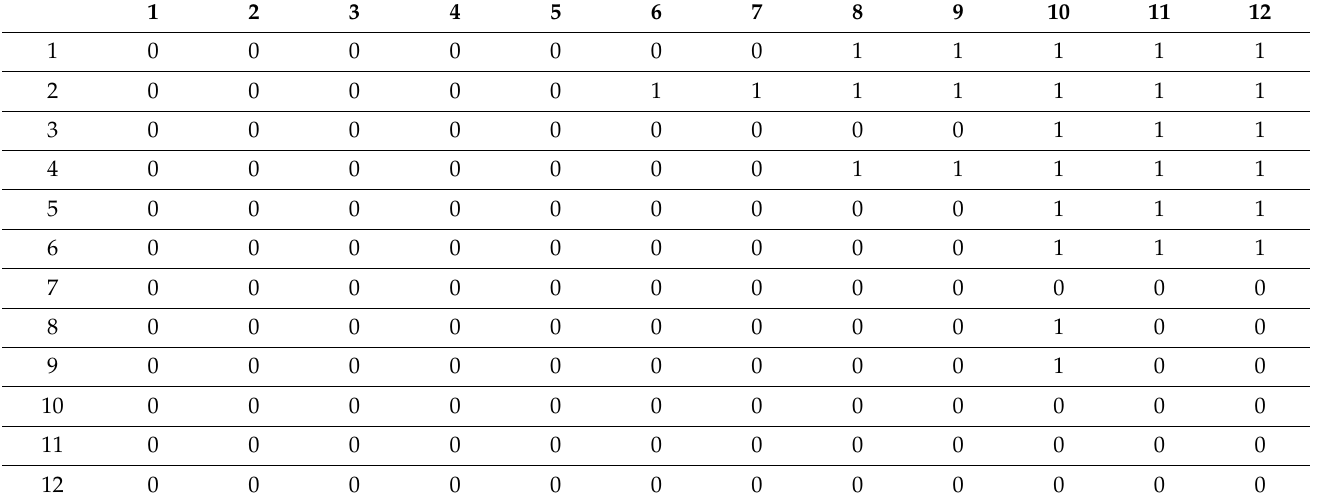
Table 7. Hasse matrix.